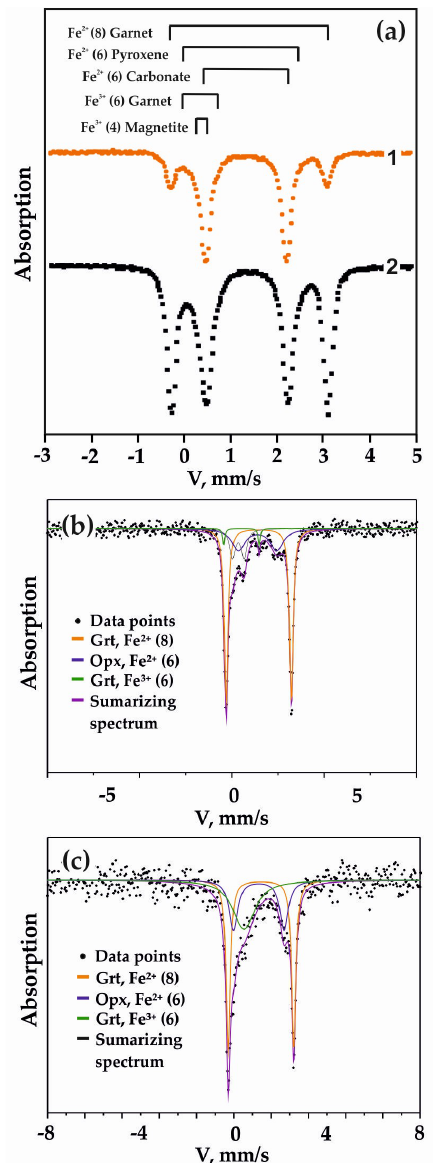
Figure 4. Room-temperature Mössbauer spectra: ( a ) spectra of different zones of samples after “sandwich”-type experiments at 7.5 GPa, T = 1550 °C ((1) quenched carbonate–silicate melt; and (2) polycrystalline garnet aggregate with quenched melt in interstices); and ( b , c ) spectra of garnets and orthopyroxenes after “mixture”-type experiments at 6.3 GPa, T = 1400 and 1500 °C, respectively; Grt, garnet; Opx, orthopyroxene.